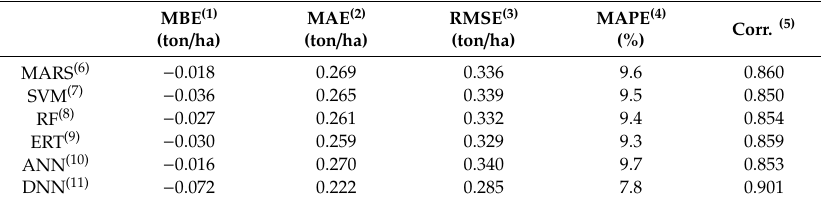
Table 7. Summary of validation statistics from 10 rounds of experiments for soybean yield: July–August (JA) (major productive period), 2006–2015.